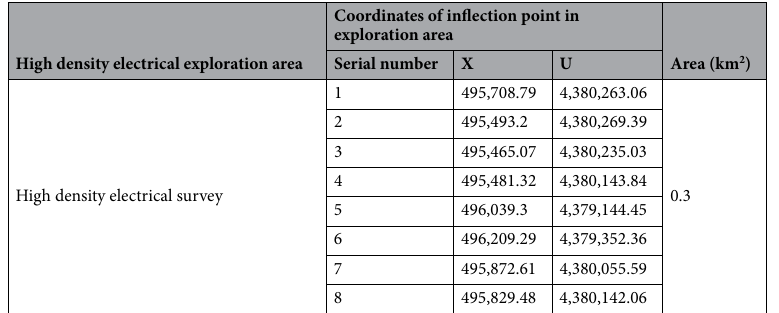
Table 3. HRM exploration scope and area. The high density electrical exploration area is composed of inflection point coordinates and the exploration area is about 0.3 km 2 .